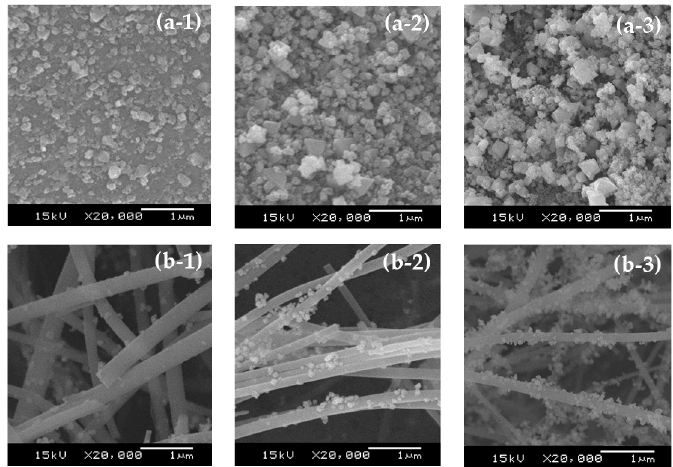
Figure 3. SEM images (20,000× magnification) for ( a ) Ni/SB and ( b ) Ni/SF catalysts containing: ( 1 ) 10 wt%, ( 2 ) 30 wt% and ( 3 ) 50 wt% Ni loading.